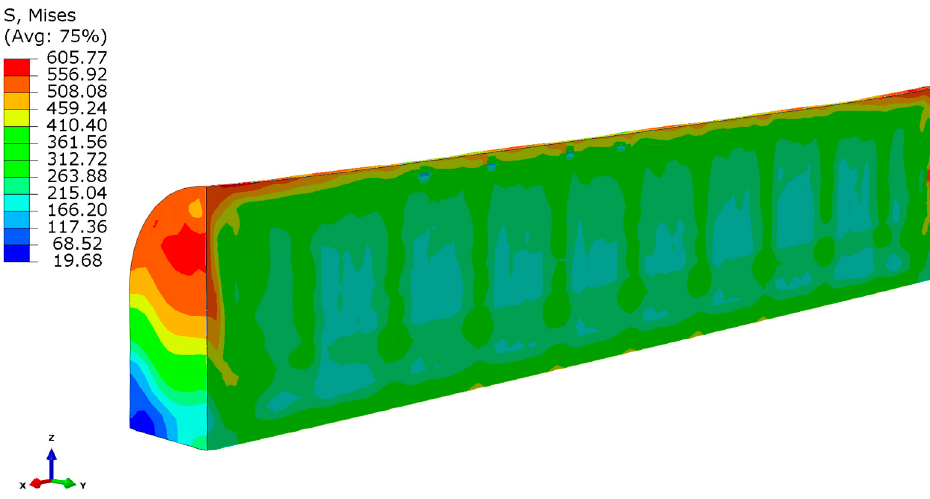
Figure 14. Equivalent stress distribution in horizontally built specimen (MPa).